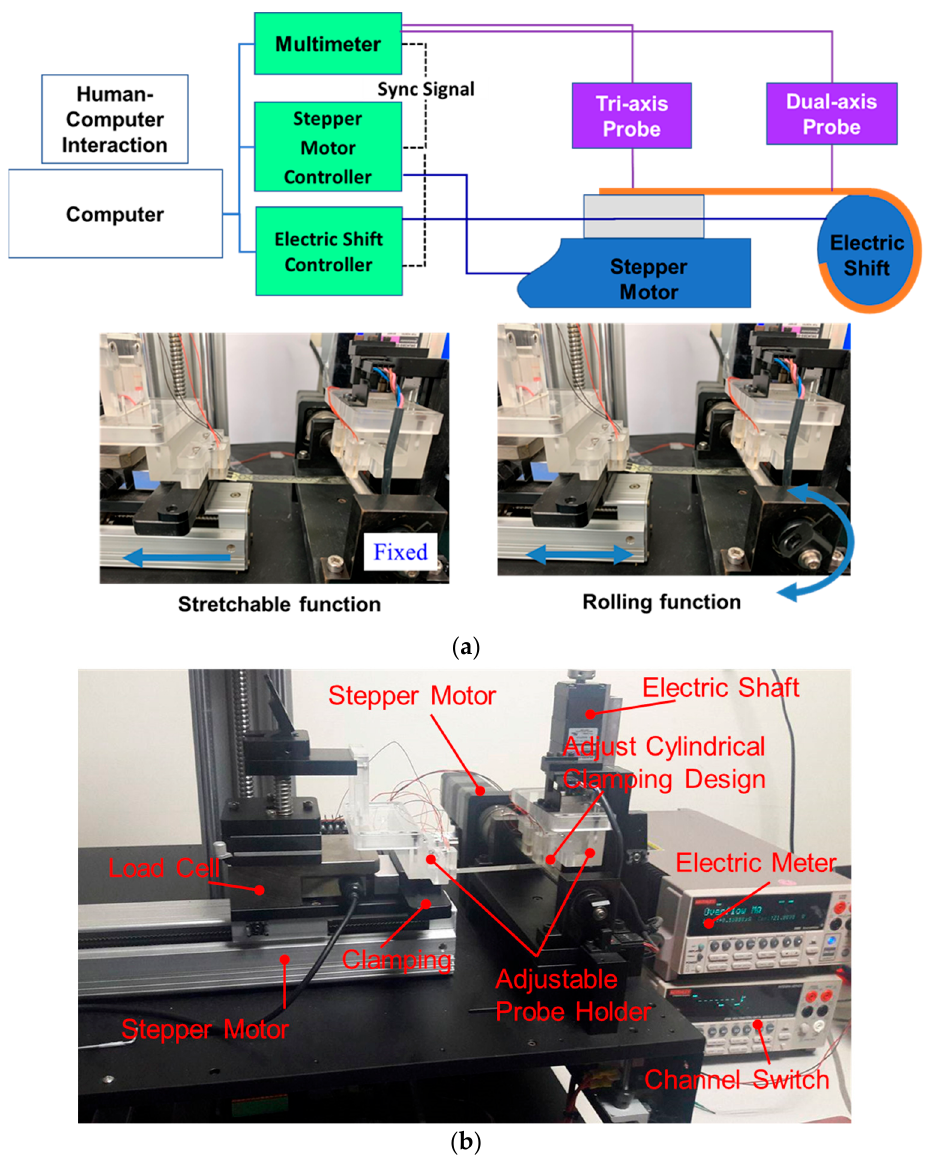
Figure 2. ( a ) Architecture diagram of the main connections of each component; ( b ) detailed components included in the actual measurement platform utilized in the mechanical loading tests of